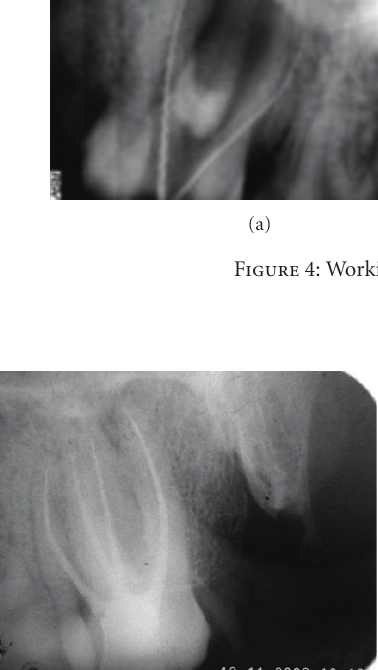
Figure 5: Postoperative radiograph showing the separation and divergence of the 4-rooted maxillary second molar.